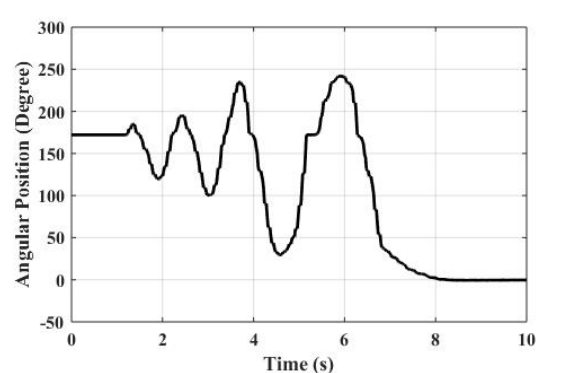
Figure 4. Inverted pendulum simulation result.